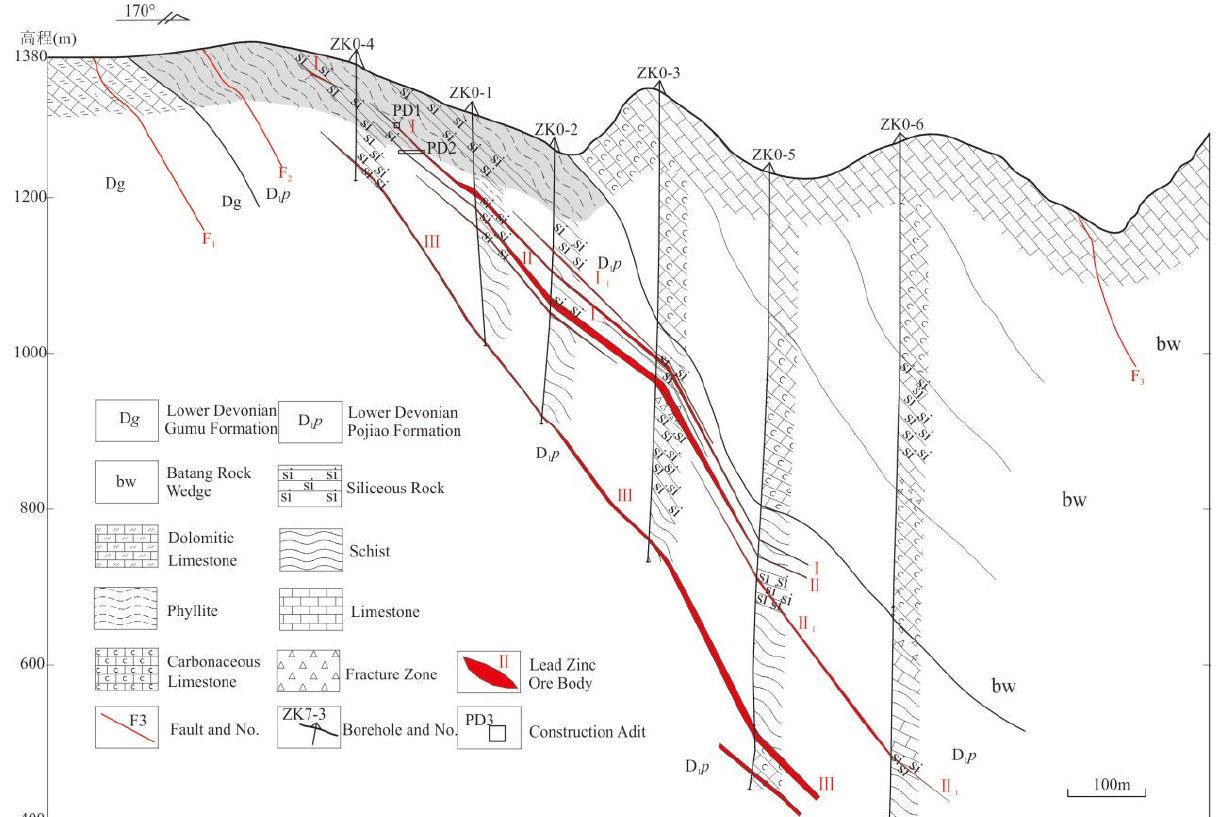
Figure 2. Geological map of mining area.